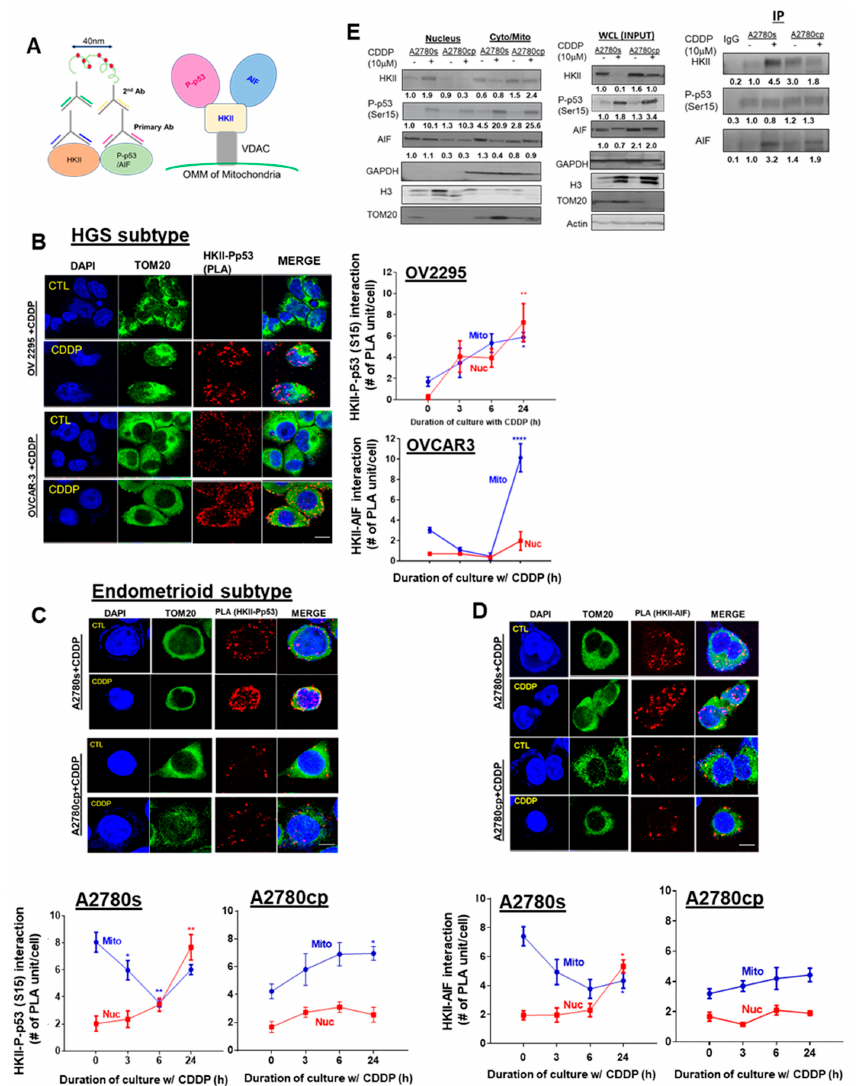
Figure 6. CDDP promotes interaction and intracellular trafficking of P-p53 (Ser 15)–HKII–AIF in the nucleus in chemosensitive OVCA cells. ( A ) Schematic diagram of the Duolink assay illustrating binding between HKII and P-p53 (Ser15)/AIF, and the molecular interaction (P-p53 (Ser15)–HKII–AIF) that was examined. ( B , C ) Examination of the nuclear interaction of the HKII-P-p53 (Ser15) PLA signal in different EOC subtypes. OV2295 and OVCAR-3 (HGS), and A2780s and A2780cp cells (endometrioid) were cultured with CDDP (10 µ M; 24 h; DMSO as a vehicle). Interaction of ( D ) HKII–AIF in A2780s and A2780cp cells was assessed by using a Duolink Image Tool (Number of PLA units (A: red spot) with counter-staining of DAPI (blue), and TOM 20 (green). Error bars denote ± SEM ( n = 5). ( E ) Right panel: A2780s and A2780cp cells were treated with CDDP (0–10 µ M; 24 h). The nuclear fraction, cytoplasmic/mitochondrial combined fractions, and whole-cell lysate (WCL) were prepared. Protein contents of HKII, P-p53 (Ser15), AIF, TOM20 (mitochondrial loading control), histone H3 (nuclear loading control), GAPDH (cytoplasm loading control), and actin (loading control for WCL) were examined by WB. Left panel: A2780s and A2780cp cells were treated with CDDP (0–10 µ M; 24 h). Nuclear fractions were collected and immunoprecipitated with anti-IgG (control) or anti-P-p53 (ser15). Protein–protein interaction was determined by IP/WB. P-p53 (Ser15) immunoprecipitates were immunoblotted (IP: anti-HKII; WB: anti-AIF). Results are expressed as mean ± SEM ( n = 3) and were analyzed by two-way ANOVA and Bonferroni post-hoc test. (* p < 0.05, ** p < 0.01, **** p < 0.0001, n =